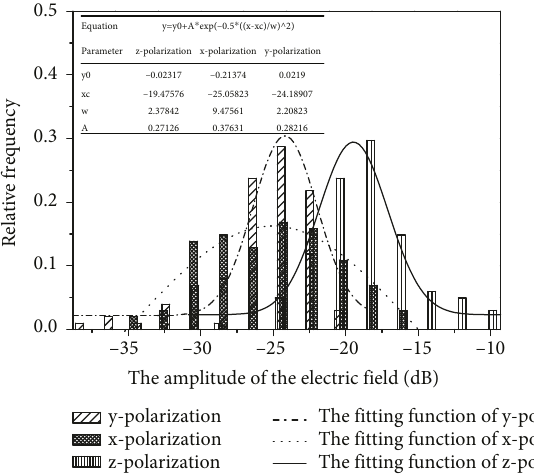
Figure 10: The probability density function (PDF) of the amplitude of the electric fi eld in the NLOS